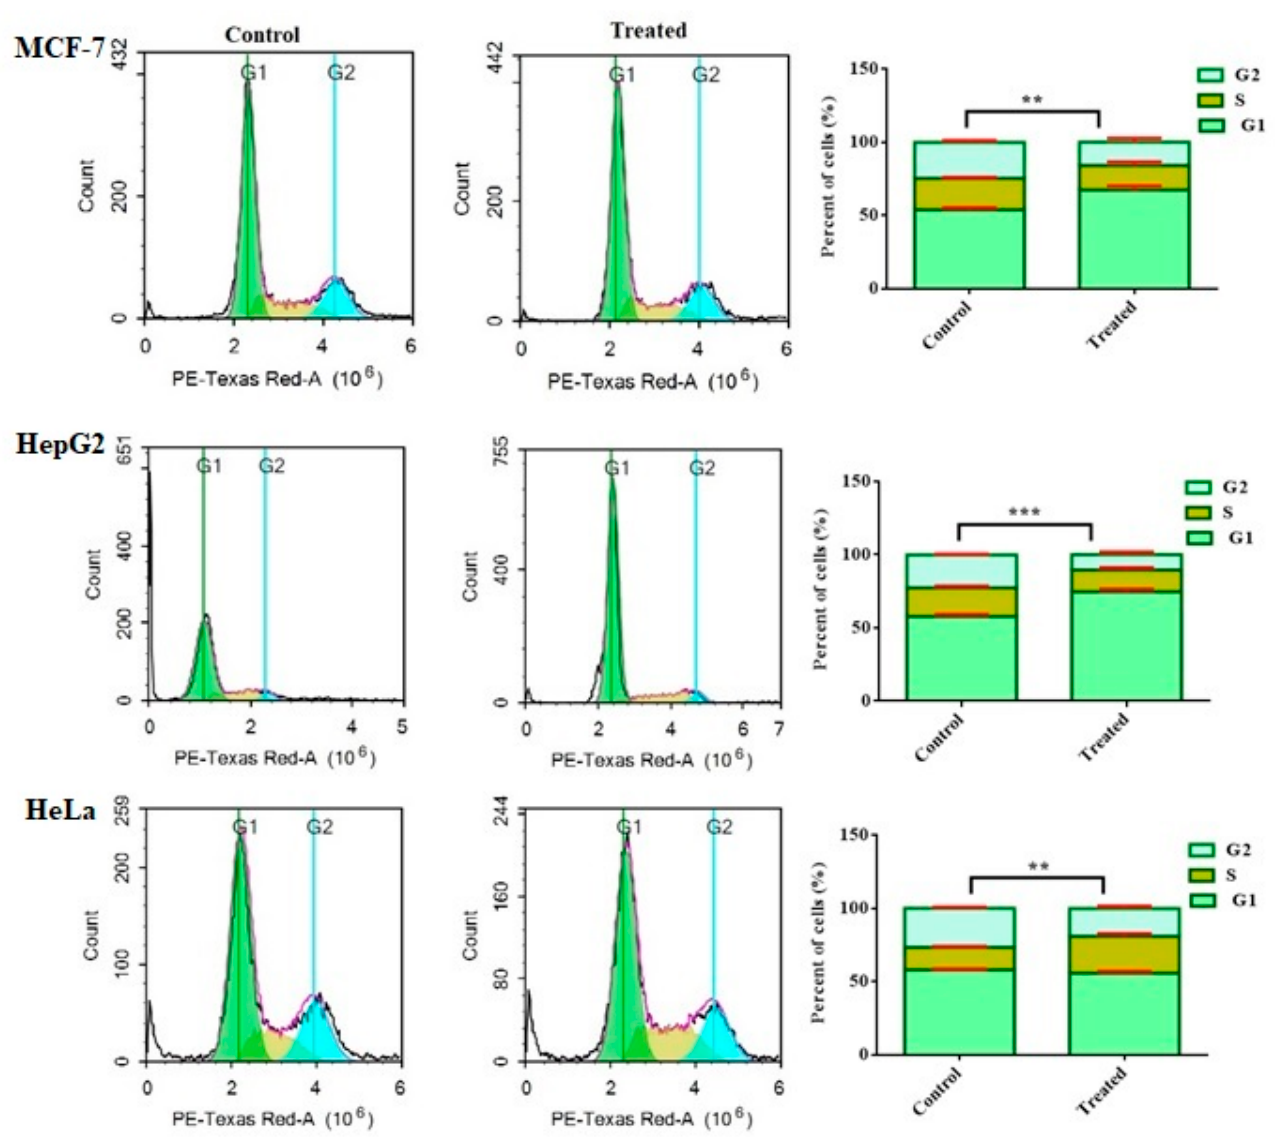
Figure 2. Effect of compound 2 on cell cycle phases of MCF-7, HepG2 and HeLa cells. Cell cycle distribution was determined using DNA cytometry analysis after exposure to 2 for 48 h. Data are presented as the mean ± SD; n = 3; ** p < 0.01 and *** p < 0.001.